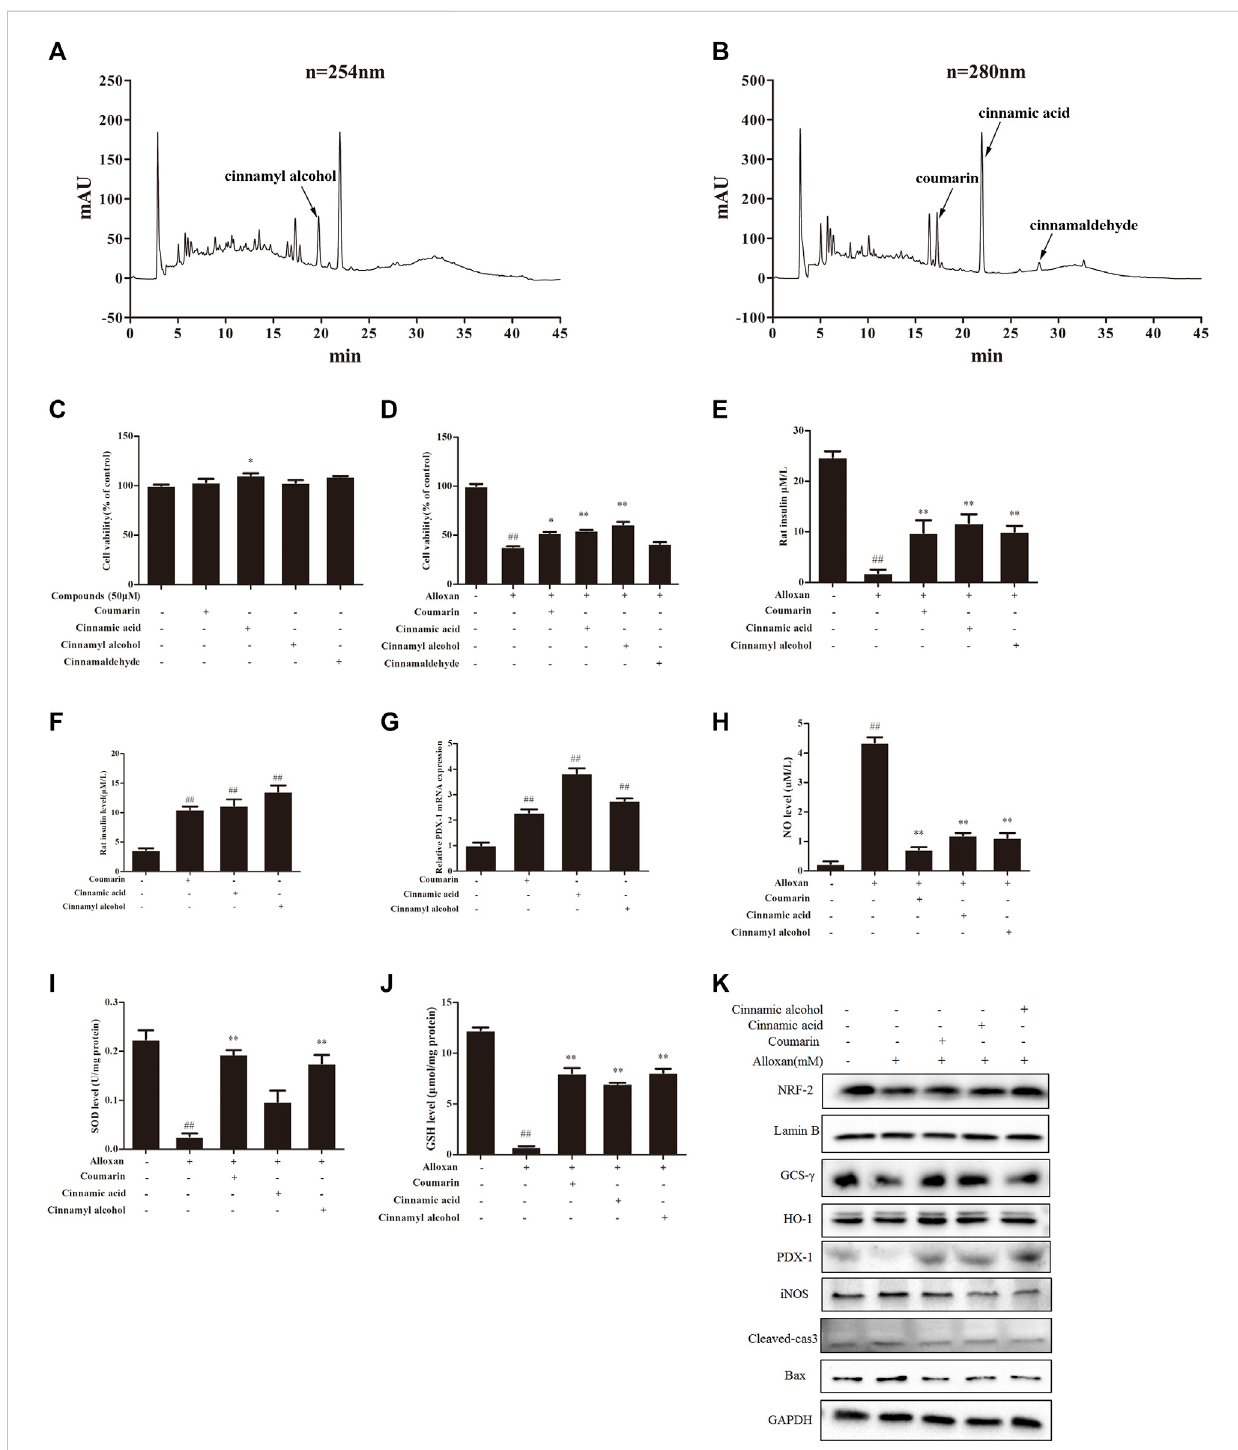
FIGURE 5 Major compounds of EA and their protective effect on β cells. Chemical pro fi les of EA were analyzed through HPLC and the effects of major functional compounds of EA on INS-1 cells were detected. (A,B) Chromatographic patterns from HPLC of EA shows peaks corresponding to retention times (min). INS-1 cells were incubated/not incubated with the main compounds (50 μ M) of EA and alloxan for 24 h. The effect of compounds on the viability of INS-1 cells was determined by the CCK-8 assay (C,D) . The effect of three compounds (coumarin, cinnamic acid, cinnamic alcohol) in EA on KCl-stimulated insulin secretion in INS-1 cells under alloxan-induced toxicity (E) , basal glucose-stimulated insulin secretion in INS-1 cells (F) , mRNA expression of PDX1 in INS-1 cells (G) , NO release (H) , activity of SOD (I) , level of reduced GSH (J) , expression of antioxidant- and apoptosis-related proteins (K) .Dataarethemean±SEM.n=3. # p < 0.05comparedwithcontrol, ## p < 0.01comparedwithcontrol,* p < 0.05comparedwiththeOS-model group, ** p < 0.01 compared with the OS-model